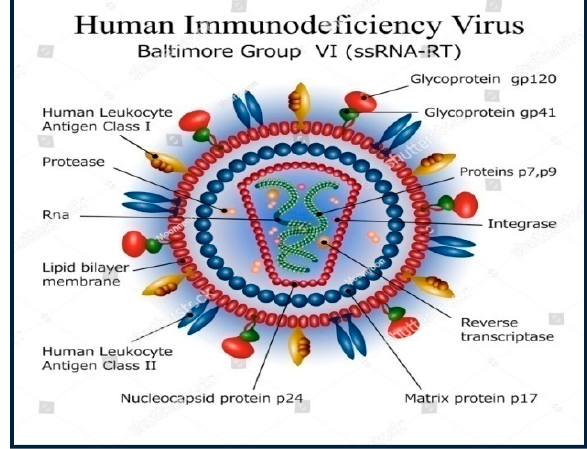
Figure 1. Structure of human immunodeficiency virus (HIV) virus [10]. Image was originally published within Open Access license.